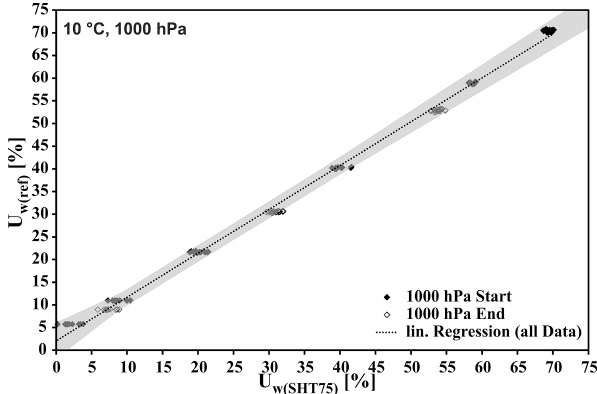
Figure 7. U w ( SHT75 ) values at 10 ◦ C and 1000hPa of all SHT75 at the start and end of the 136 days test time; expanded uncertainty area marked in